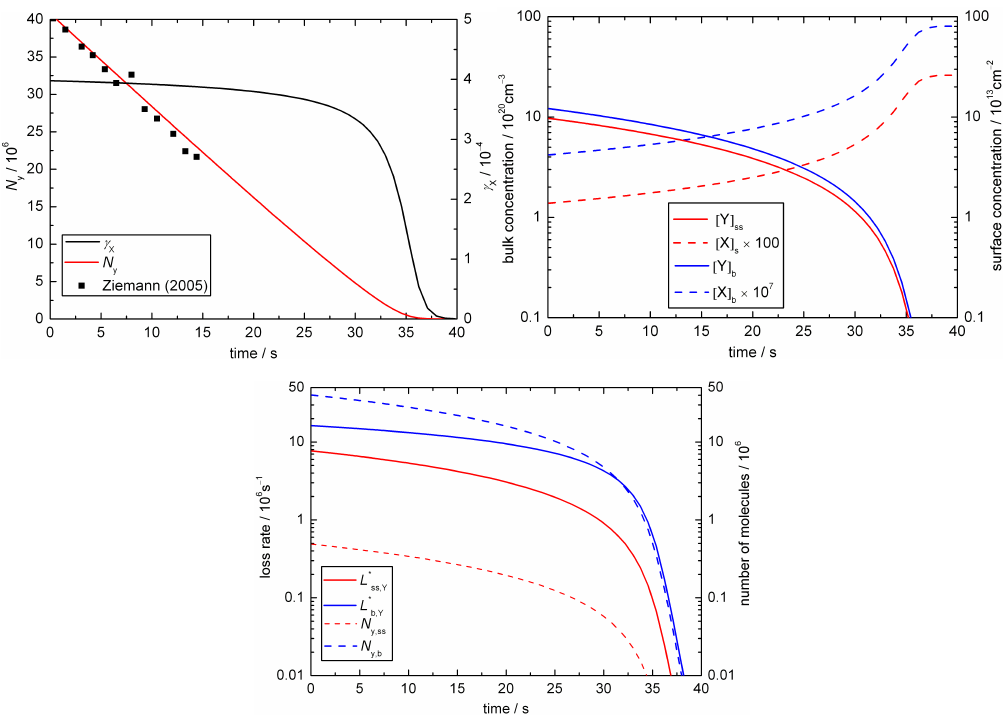
Fig. 2. Temporal evolution of aerosol particle composition and kinetic parameters in base case 1 (BC1; X = O 3 , Y = oleic acid): (a) ozone uptake coefficient ( γ x ) and total number of oleic acid molecules ( N y ; symbols indicate experimental data from Ziemann, 2005); (b) surface and bulk concentrations (square brackets); (c) numbers of oleic acid molecules at the surface and in the bulk of the particle ( N y , ss , N y , b ) and = L ss , Y × A ss , L ∗ = L × V corresponding absolute loss rates ( L ∗ b , Y b ) ss , Y b , Y